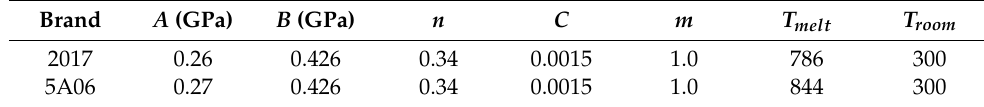
Table 1. Material properties of Johnson–Cook strength model.